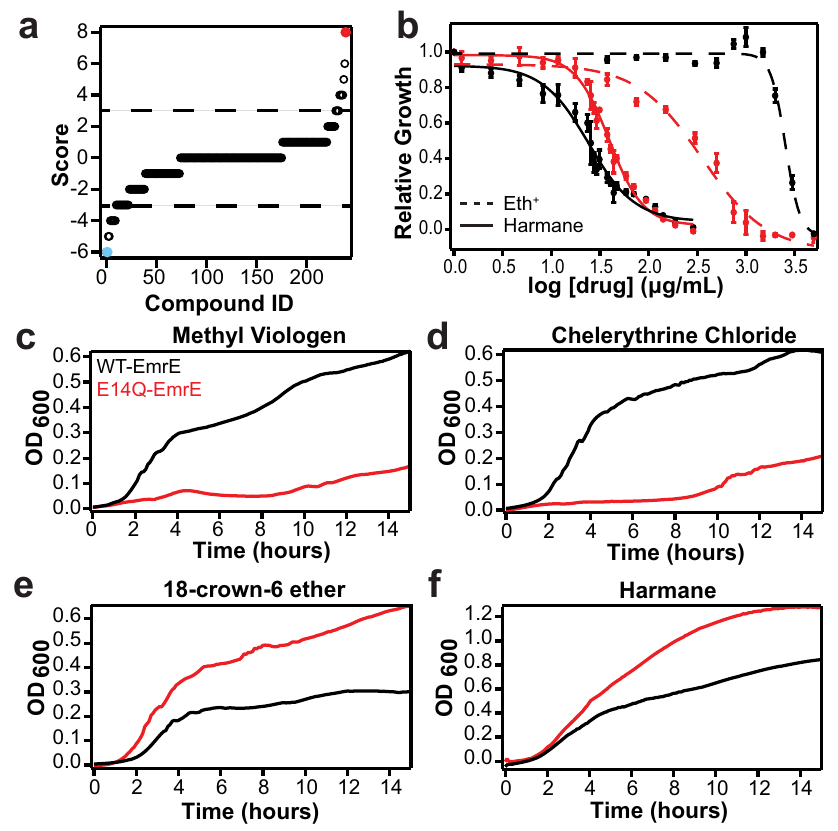
Fig. 2 | EmrE can confer either resistance or susceptibility in vivo. a Biolog phenotypemicroarrayresultsweresortedbyhitscoreforall240compoundsinthe screen (see Methods). Scores above +3 or below − 3 are considered resistance or susceptibility hits, respectively, based on the differential between functional (WT) and nonfunctional (E14Q-EmrE). The strongest resistance hits (red) and suscept- ibility hits (cyan) were tested in growth assays (C-F). b IC 50 curves of WT- (black) andE14Q-EmrE(red)areshownforethidiumbromide(dashedlines,resistance)and harmane (solid lines, susceptibility). N =3 biologically independent bacterial colo- nies were examined over three independent experiments. Data were presented as mean value±SD. Note that cells expressing WT-EmrE have a 40% lower IC 50 value